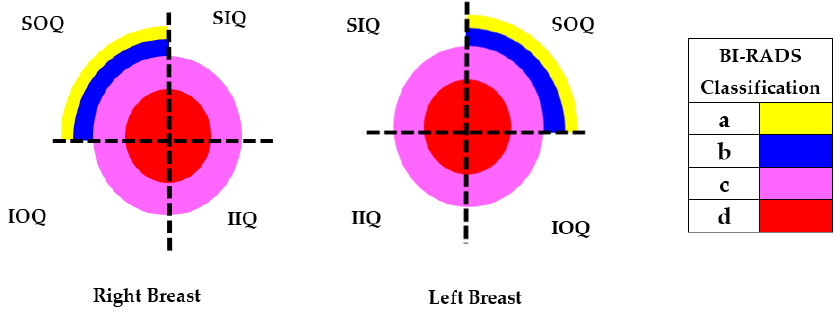
Figure 3. Proposed ATC concentric zones according to the BI-RADS classification.